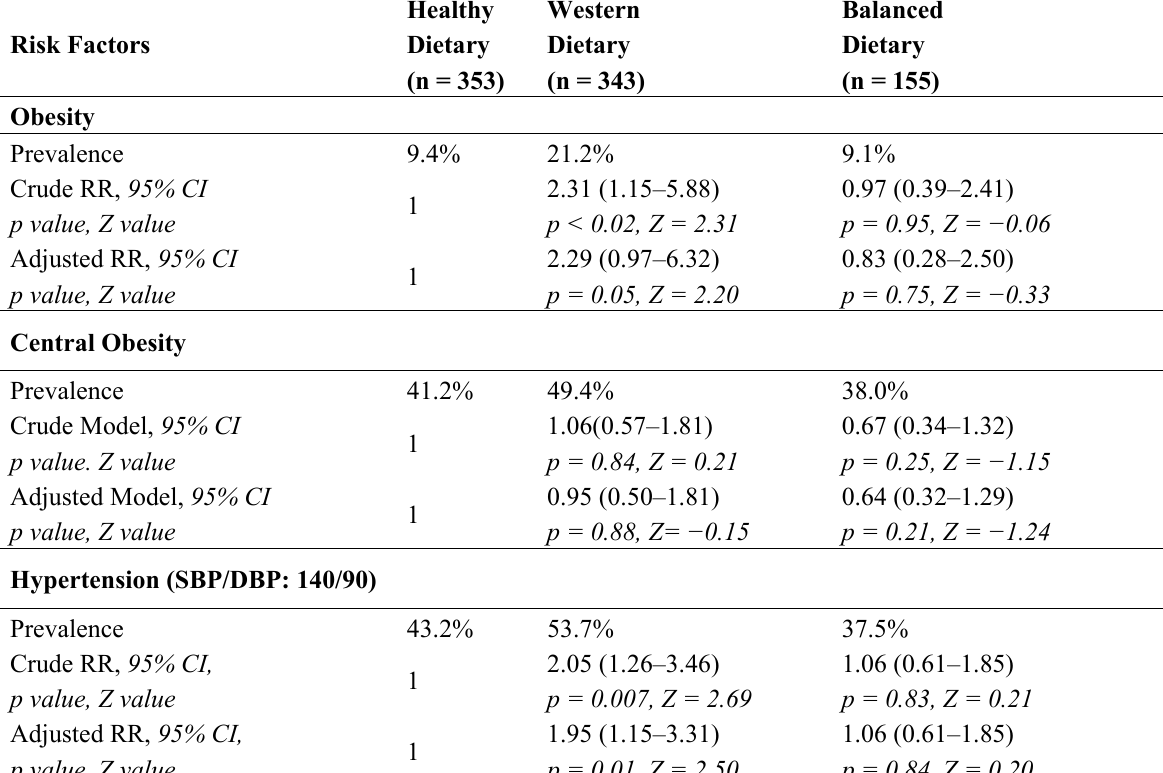
Table 6. Prevalence and relative risk (RR) of chronic disease related risk factors according to dietary